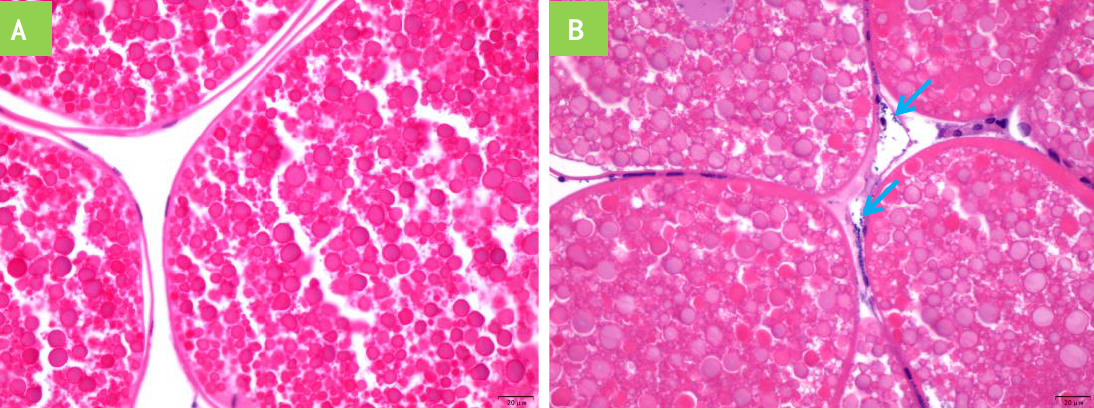
Figure 3. Ovarian tissue sections of a healthy crab and of a crab after Metschnikowia bicuspidata infection. ( A ) A healthy crab (400×). ( B ) A diseased crab; the arrow indicates that Metschnikowia bicuspidata can enter the ovarian tissue, but not the oocyte (400×).